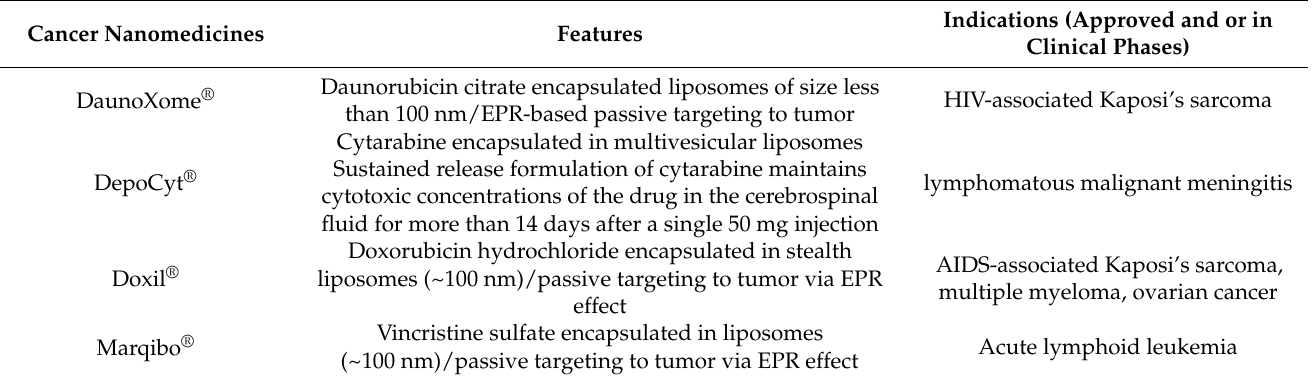
Indications ( Approved and or in